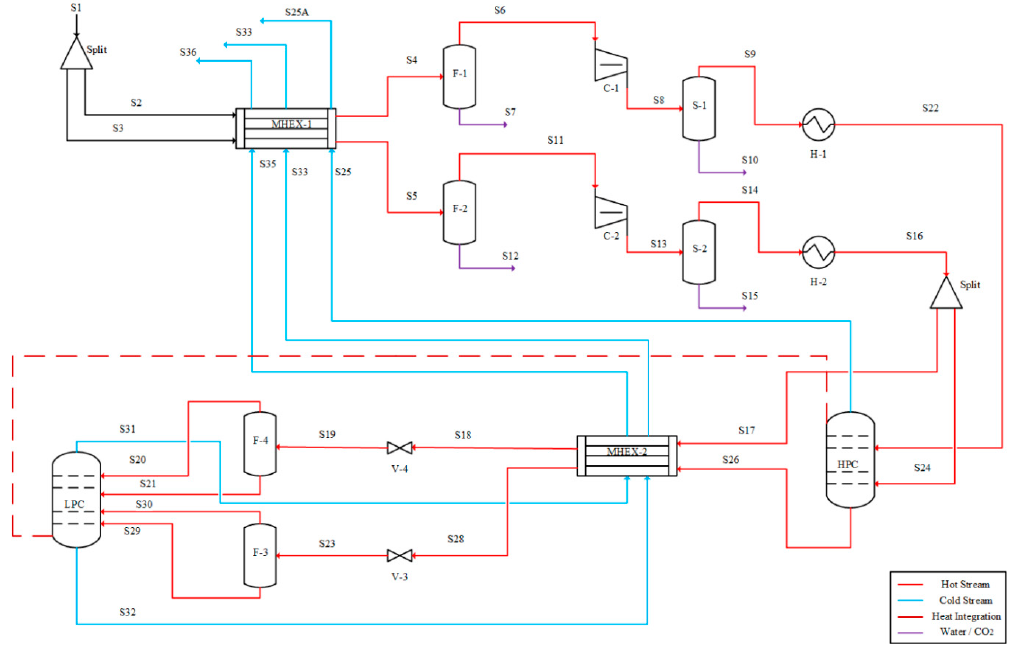
Figure 7. Process flow diagram of the ASU configuration C7. Table 7. Steady-state simulation results for the ASU configuration